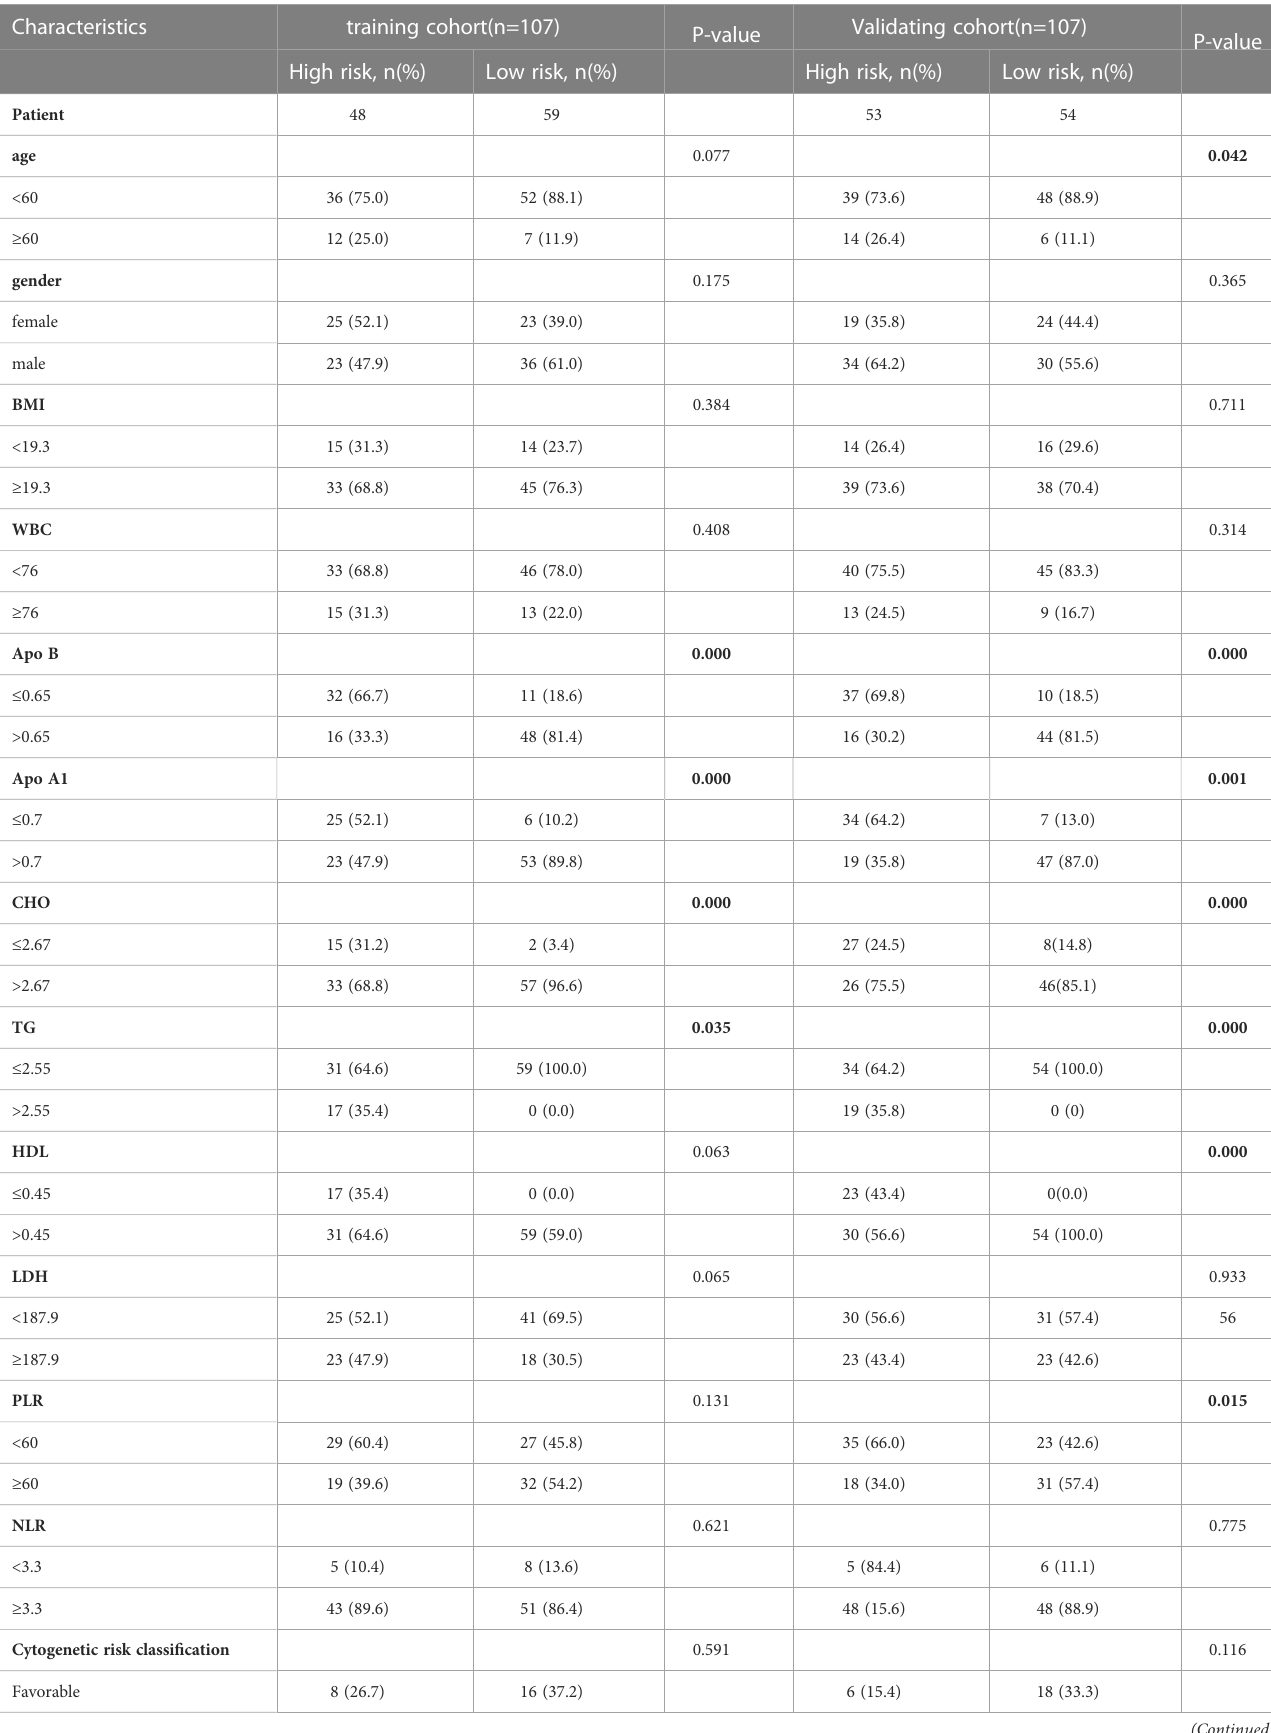
TABLE 2 The detailed characteristics of patients and correlation between clinicopathological features and risk score level in the training and validation cohorts.